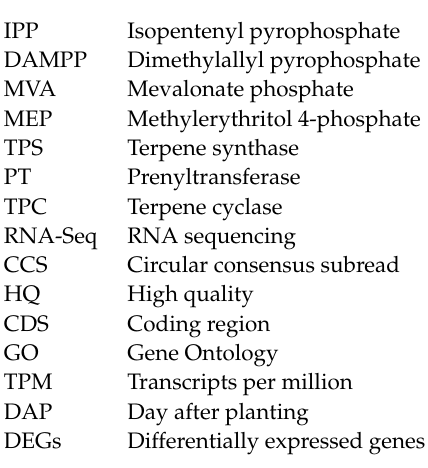
CYP450; Figure S2: qRT-PCR test of the genes involved in sterol and saponin biosynthesis via the MVA pathway; Figure S3: qRT-PCR analysis of the genes involved in carotenoid and iridoid production via the MEP pathway; Figure S4; qRT-PCR test of the three IDI-encoding genes; Table S1: Statistical results of Illumina RNA sequencing from 18 individual tissue samples; Table S2: Statistical results of Pac-Bio sequencing; Table S3: Mapping results of reads produced from 18 individual RNA samples; Table S4: Expression information with annotation of unigenes; Table S5: GO analysis of up-regulated DEGs (Cutoff: FDR < 0.01, p -value < 0.01, FC > 1.5); Table S6: GO analysis of down-regulated DEGs (Cutoff: FDR < 0.01, p -value < 0.01, FC > 1.5); Table S7: KEGG analysis of up-regulated DEGs (Cutoff: FDR < 0.01, p -value < 0.01); Table S8: KEGG analysis of down-regulated DEGs (Cutoff: FDR < 0.01, p -value < 0.01); Table S9: Expression and clustering of genes involved in MVA and MEP pathways; Table S10: Expression and clustering of TPS-encoding genes; Table S11: Expression and clustering of genes involved in saponin and sterol biosynthesis; Table S12: Expression and clustering of genes involved in carotenoid biosynthesis; Table S13: Expression and clustering of genes involved in two iridoid pathways; Table S14: Clustering of CYP450-encoding genes co-expressed with secologanin biosynthesis genes; Table S15: Co-expression clustering of genes involved in terpenoid metabolism; Table S16: Information of nucleotide sequences and oligo primers used for qRT-PCR of target